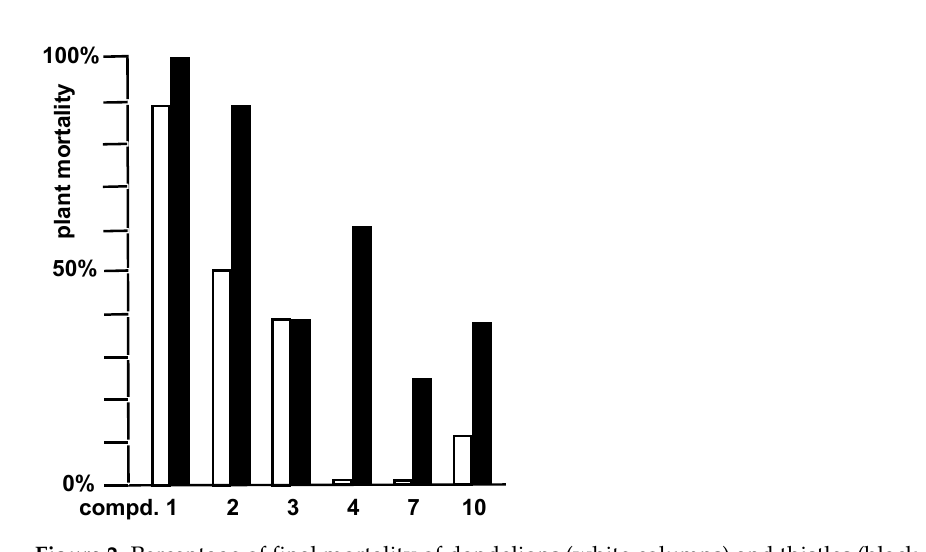
Figure 2. Percentage of final mortality of dandelions (white columns) and thistles (black columns) treated with 0.2 mL/plant of 100–150 mM solutions of active macrocidin derivatives after two to six weeks. Mortality by diflufenican was 100% for either plant species.